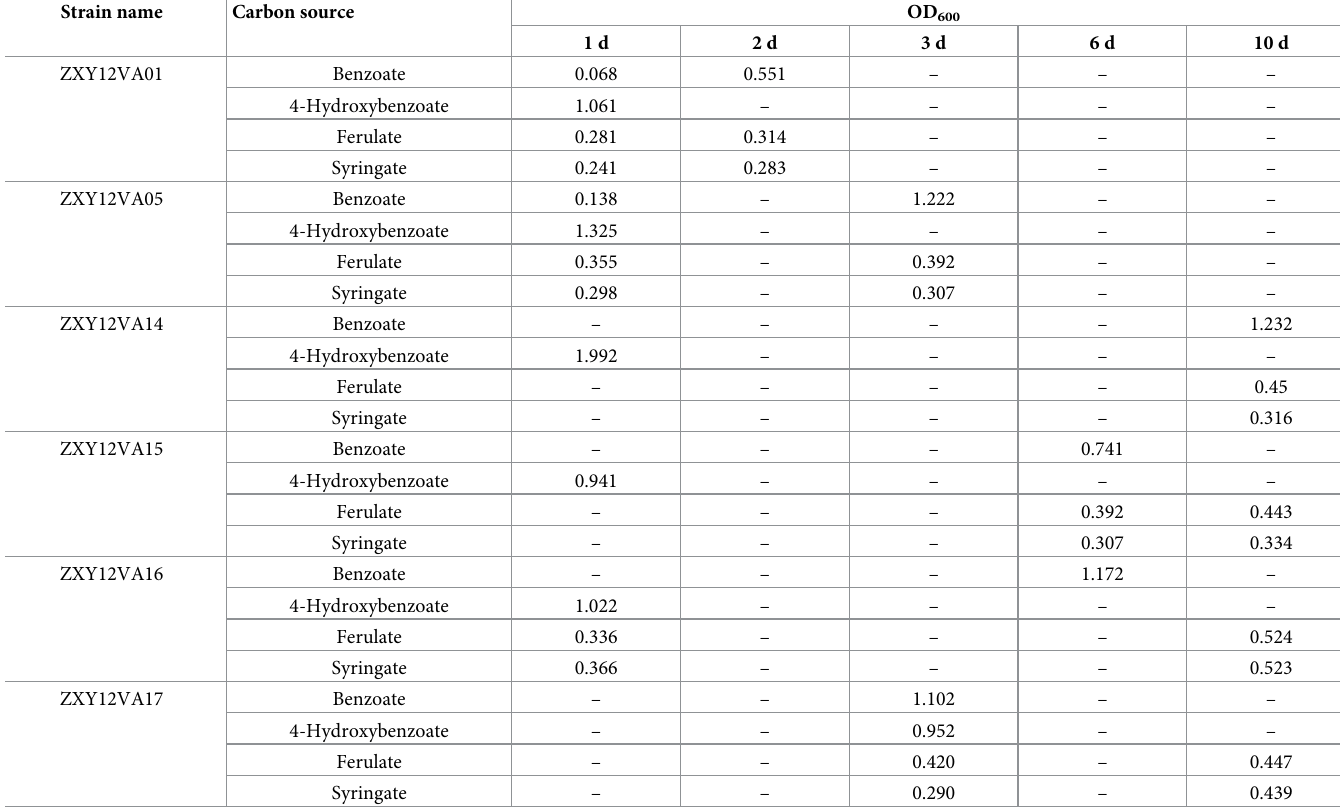
Table 2. Vanillate-degrading isolates grown on different lignin-derived carbon